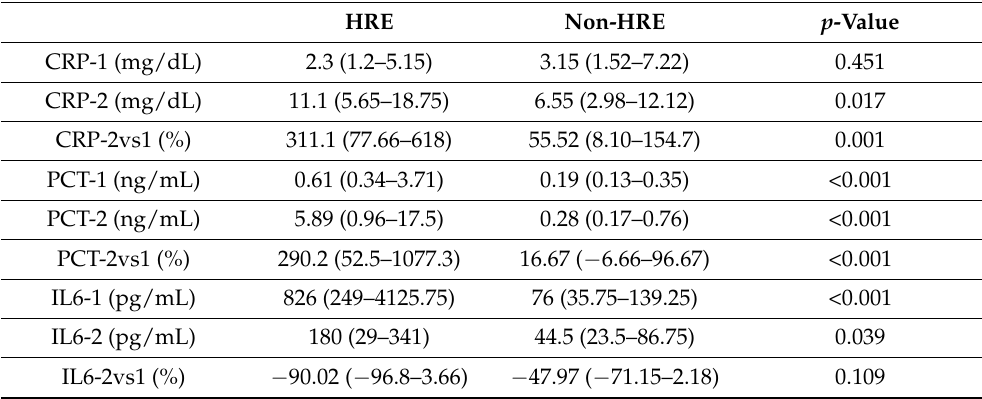
Table 2. Median and interquartile range of biomarkers (absolutes values and variations) in HRE and